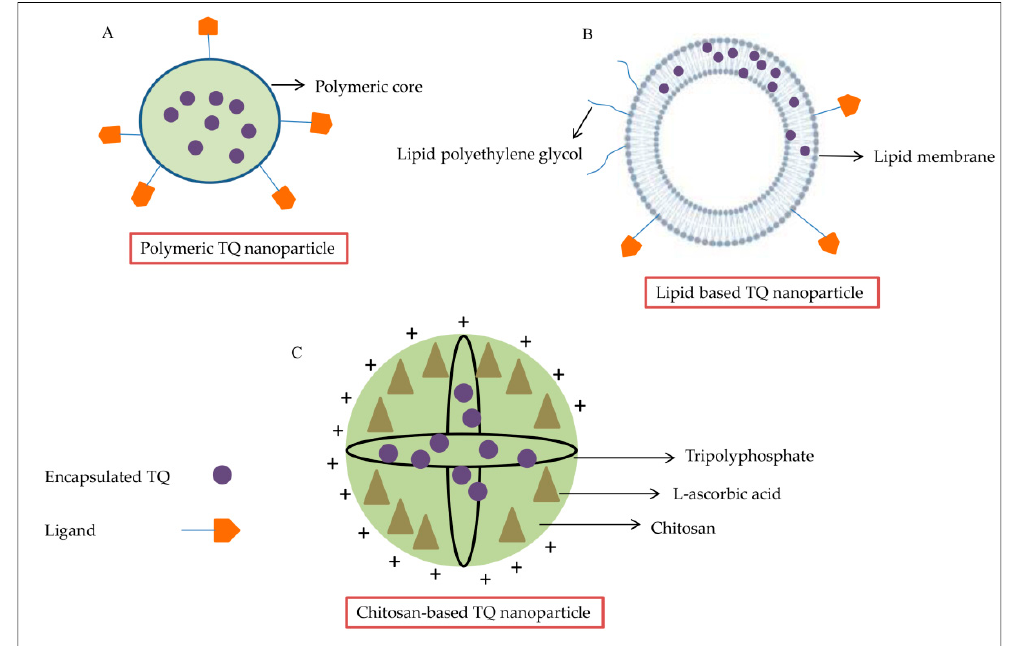
Figure 1. TQ encapsulated in different nanoparticle formulations. ( A ) TQ entrapped within the polymeric core of a polymeric nanoparticle. ( B ) Structure of lipid nanoparticle containing TQ sandwiched between two layers of charged ionizable lipids. ( C ) The chitosan nanoparticle typically possesses positive surface charges and mucoadhesive properties that can adhere to mucus membranes and release TQ in a sustained release manner.